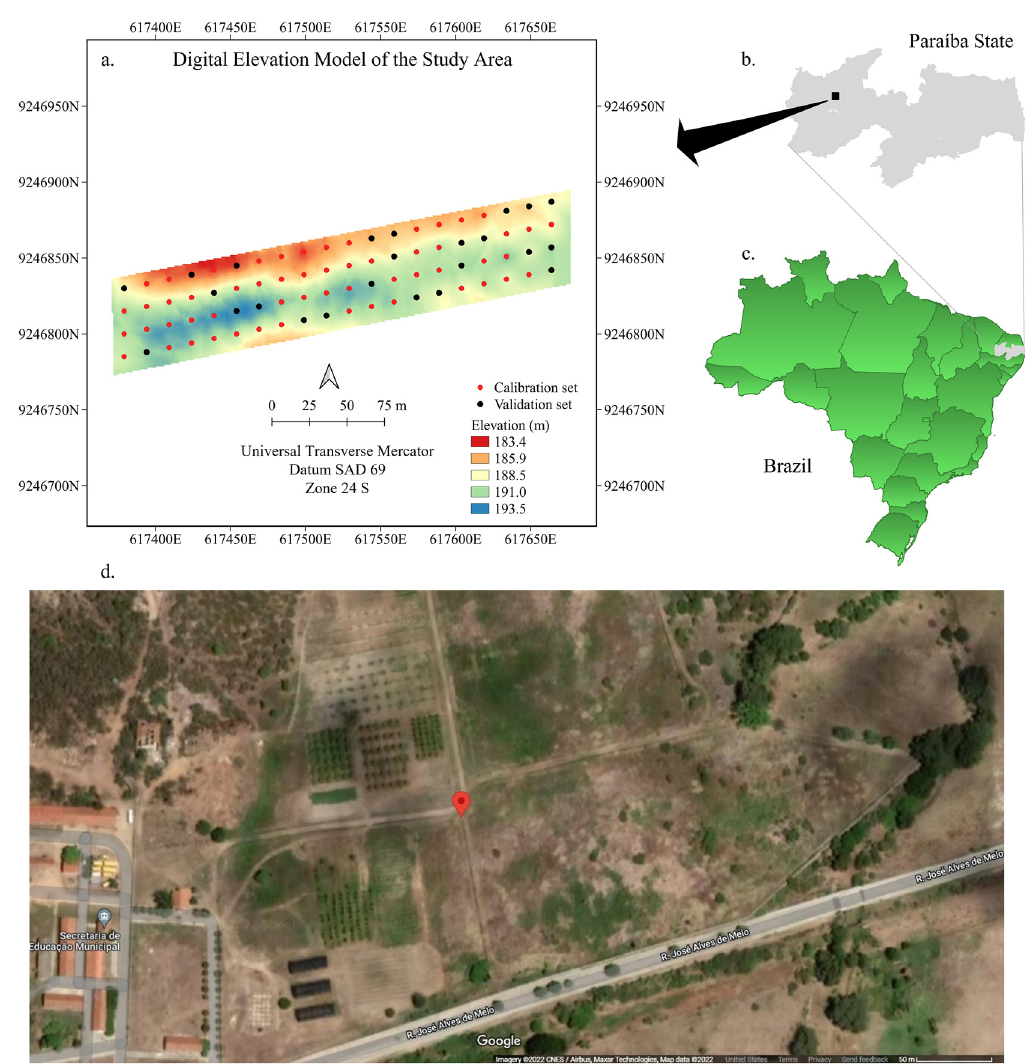
Figure 1. Geographical location of the study area. ( a ) Digital elevation model of the study area and location of the soil samples. ( b ) State of Paraíba. ( c ) Brazil. ( d ) Satellite image of the study area with the entrance indicated as red icon.